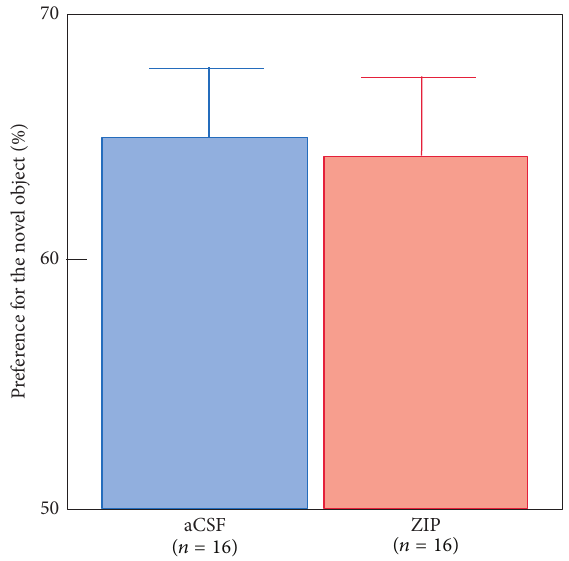
Figure 4: On the test of new learning, ZIP remote rats (light red) performed similar to aCSF remote rats (light blue) and both groups performed above chance level (chance = 50%). These data indicate intact learning after ZIP